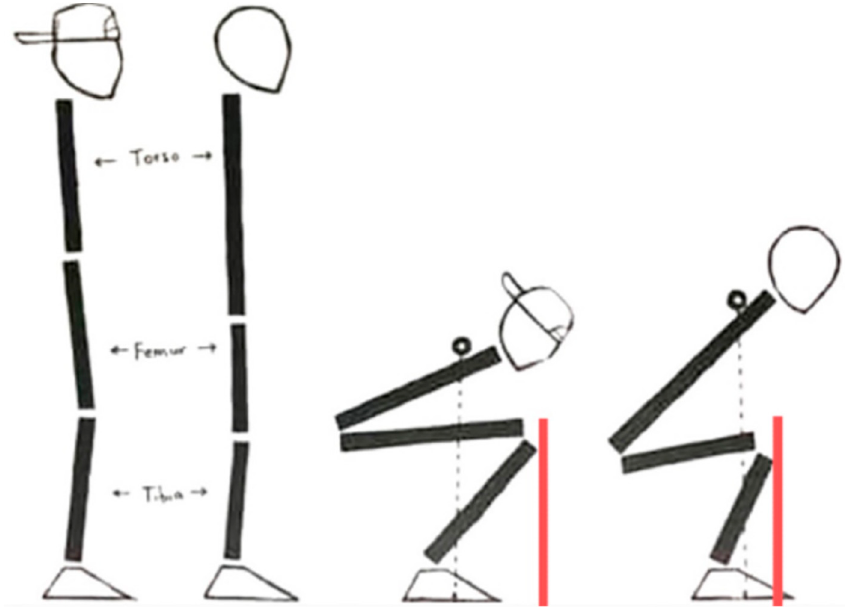
Figure 3. Anthropometry and AKD during squa tt ing—( left ): long legs/short torso vs. ( right ): short legs/long torso. Limb-to-torso-ratio a ff ects AKD when squa tt ing (red lines). Modi fi ed with permission from [70].